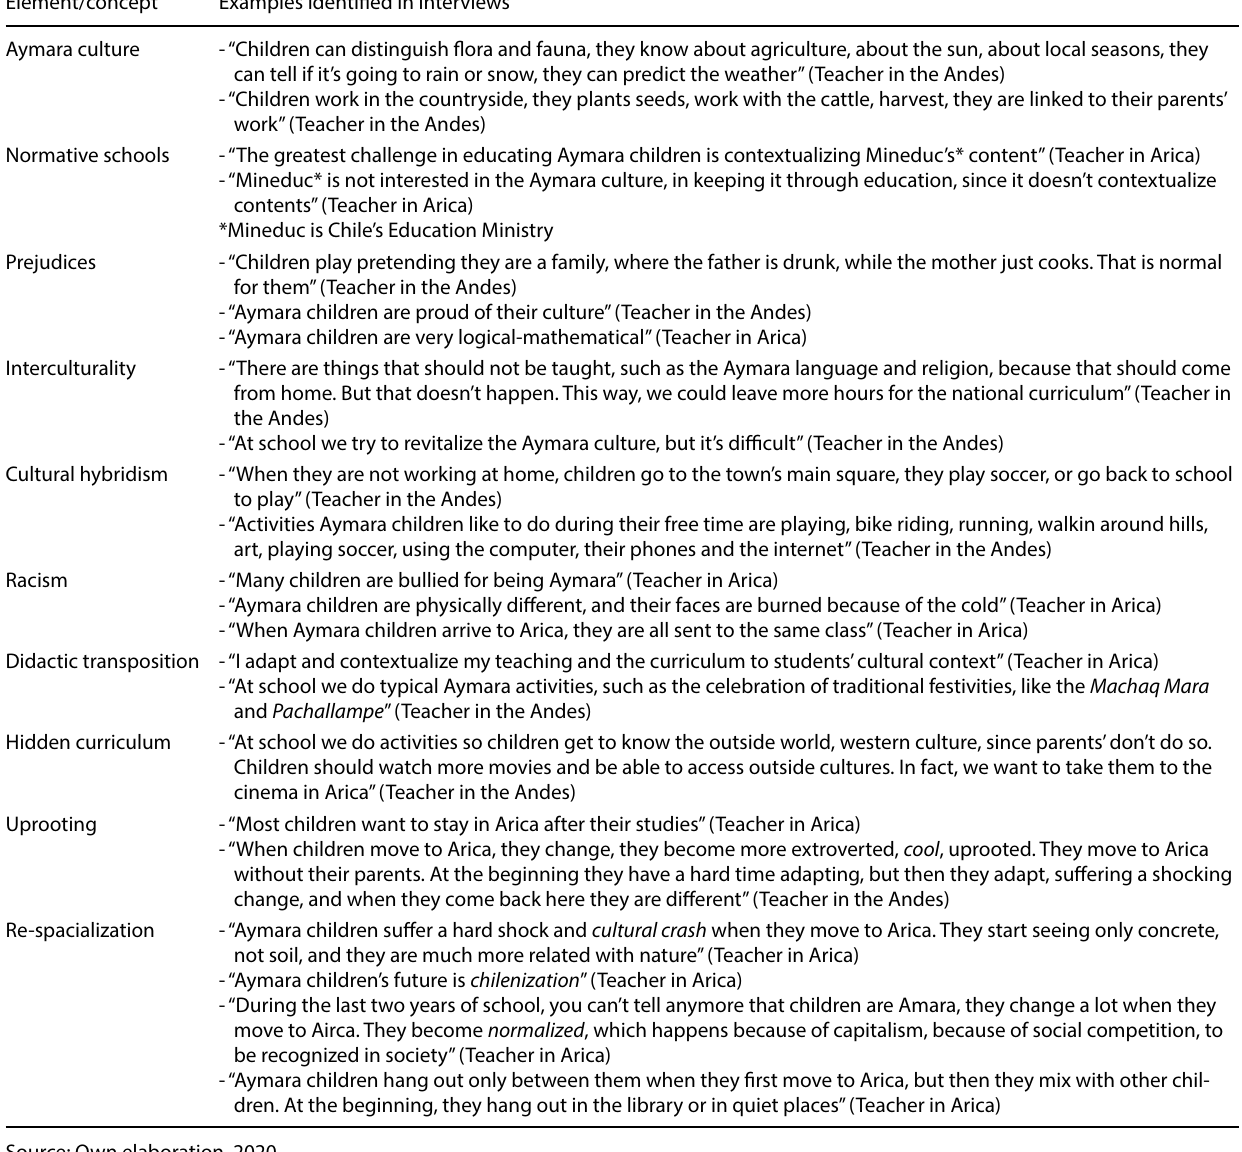
Table 1 Examples for each concept identified in